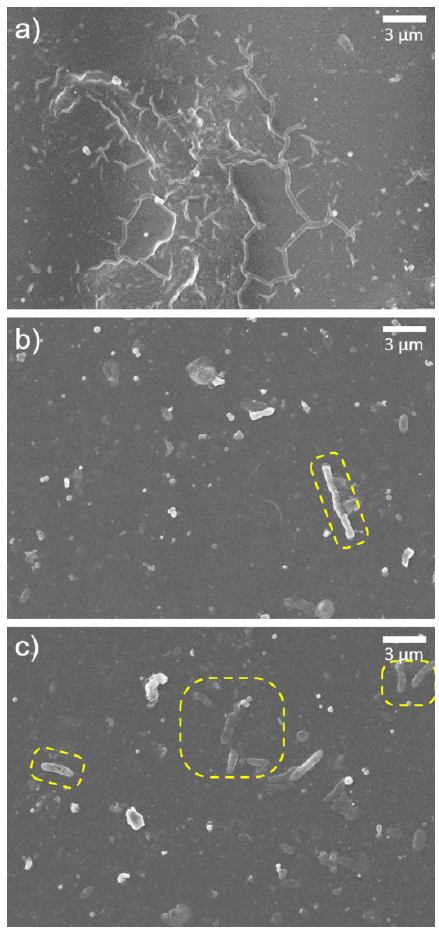
Figure 6. SEM images of ( a ) a wrinkled pattern on a GONs-TFC membrane (40 ppm) and ( b ) some- thing that seems to be o-SWNT and ( c ) microbes on an o-SWNT-TFC membrane (40 ppm). These images were acquired at 10,000× magnification after the acid resistance test.